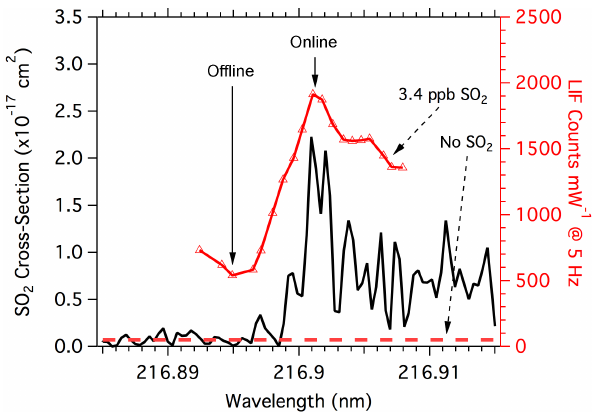
Figure 9. Example of observed signal during a scan of the laser when sampling 3.4ppb SO 2 from a gas standard during a WB-57F flight. The black line plotted on the left axis shows the literature SO 2 absorption cross section. Plotted in red against the right axis is the observed signal from the LIF system. Red dashed line shows typical signal observed when scanning laser with a zero-air